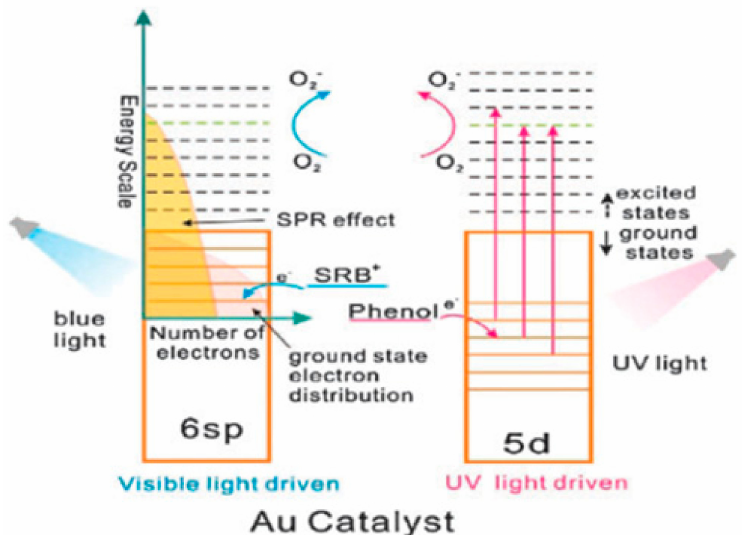
Figure 1. The energy band structure diagram of the supported Au NPs and the suggested mechanism of using the supported Au NPs for photocatalysis. Reproduce with permission from reference [14], RSC,